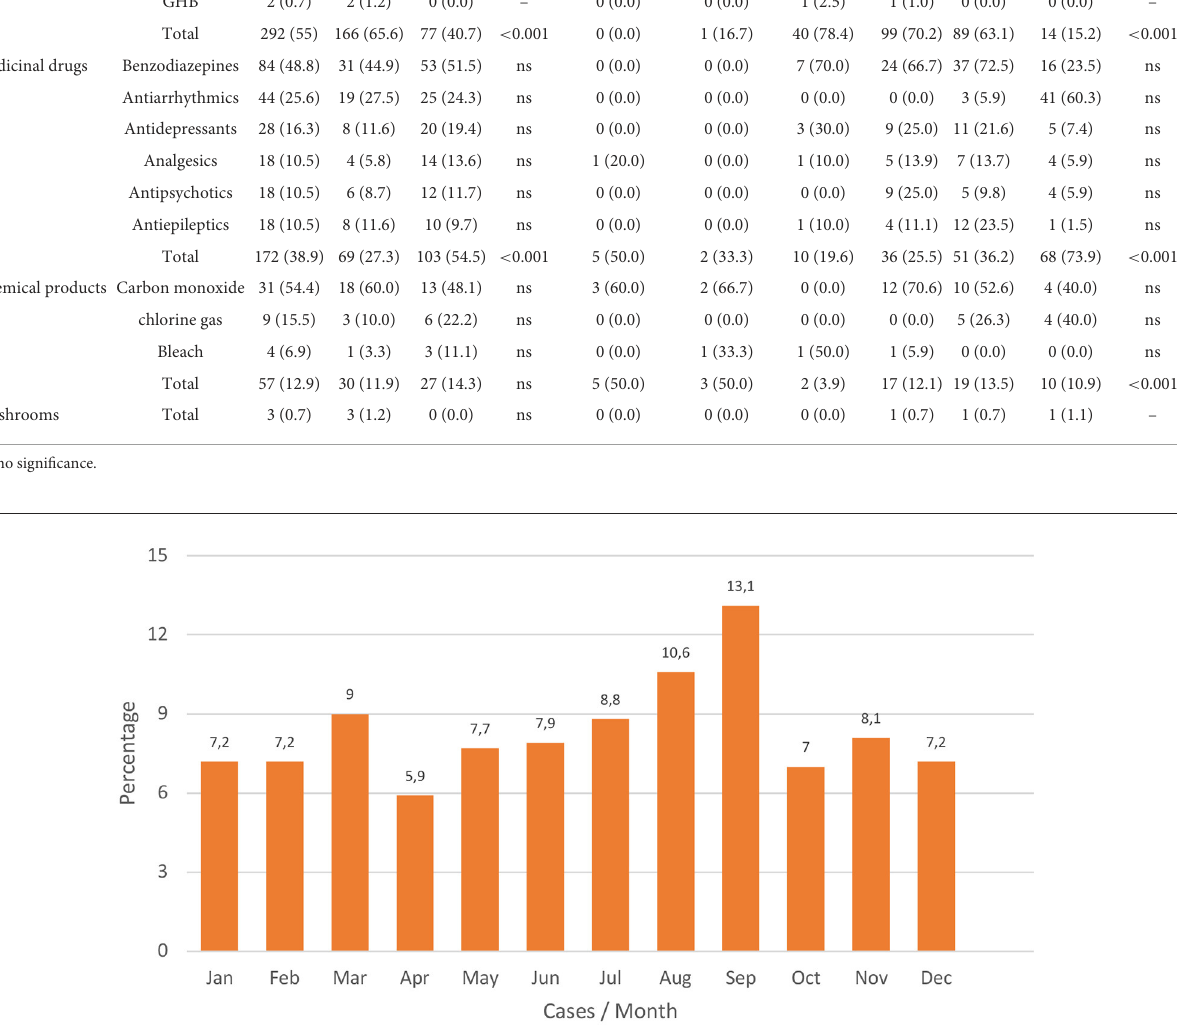
Unit (ICU) (1.1%) or to the Psychiatric Short Stay Unit (SCU) (5.5%). The average stay in the emergency room was 6h and 6min. 31.7% of emergencies were resolved in the first 2h, and